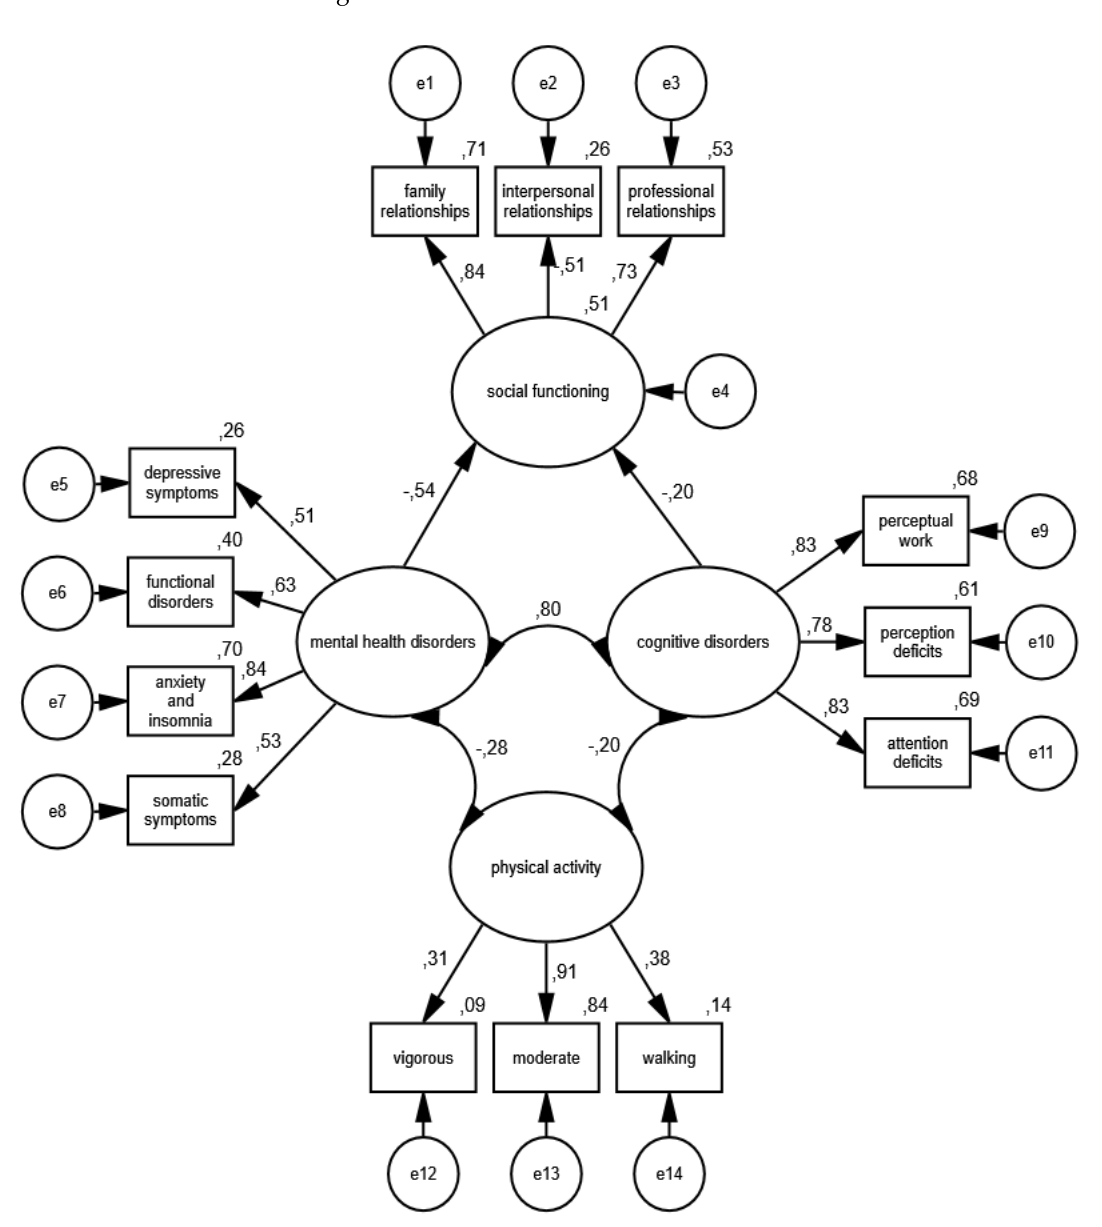
Figure 9. Standardized effects of the structural model of the relationship between physical activity and psychosocial functioning in a group of women .